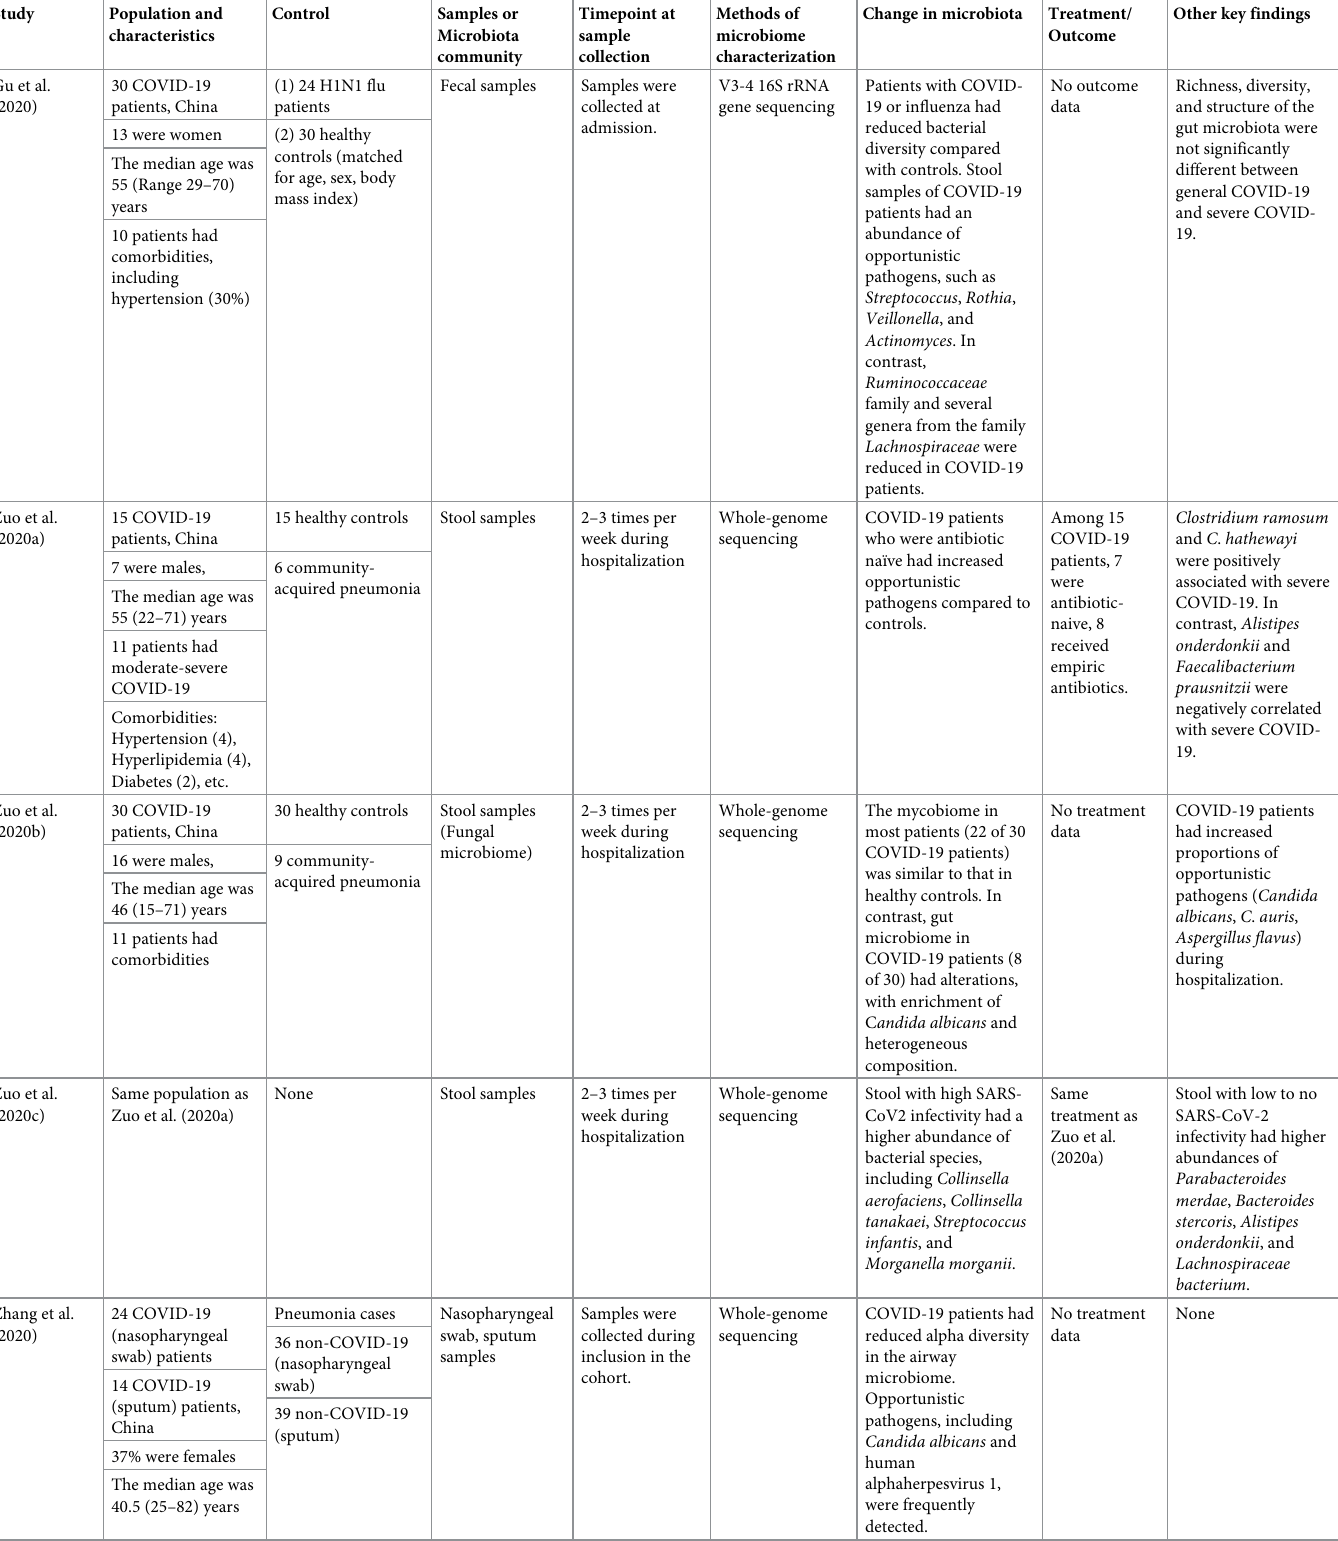
Table 1. The characteristics of all included